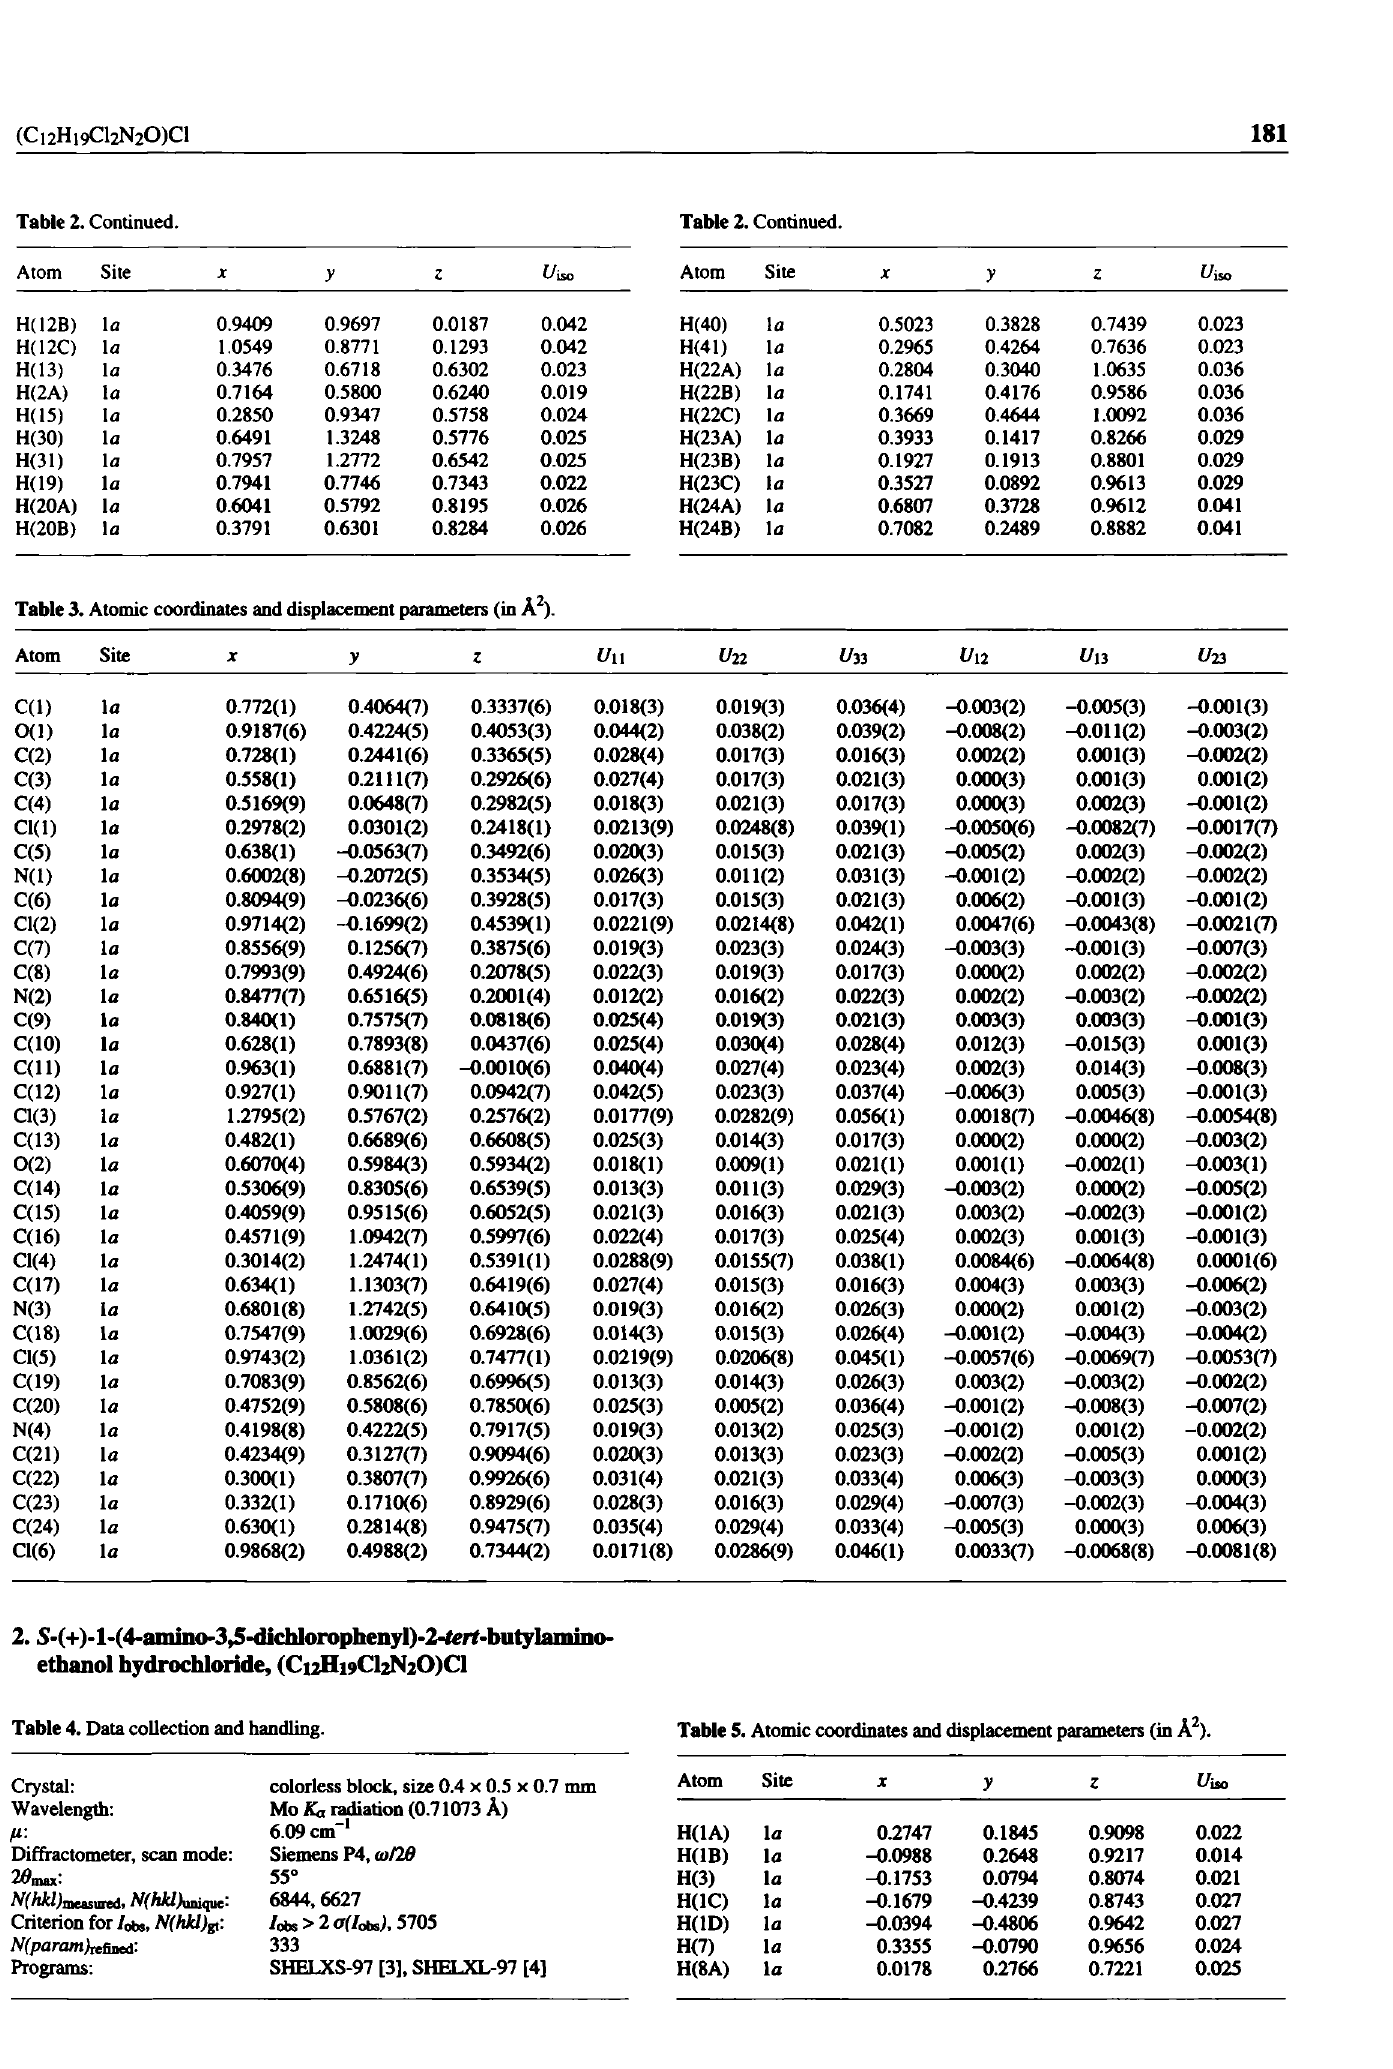
Table 4. Data collection and handling. Table 5. Atomic coordinates and displacement parameters (in A 2